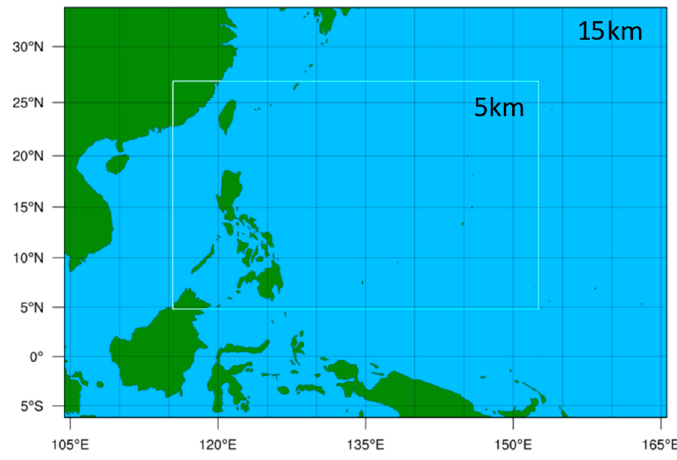
Figure 1. The two-way nested model domains, with the outer domain at 15 km resolution, and the